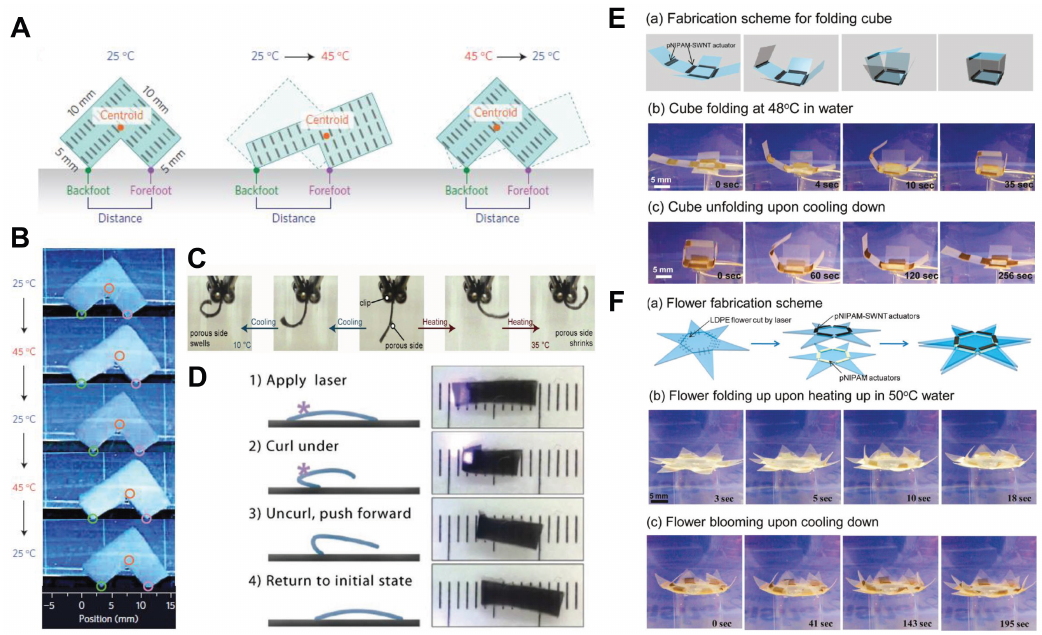
Figure 2. Thermo-responsive hydrogel actuators (HAs). ( A ) Basic diagram and mechanism for a unidirectional procession of L-shaped symmetric poly( N -isopropylacrylamide) (pNIPAM)/titanate(IV) nanosheet HAs (5 mm thick). ( B ) In the absence of substantial water uptake and release, distance between the nanosheets rapidly expands and contracts on heating and cooling, respectively, even in air, for which a hydrogel walker achieved a good forward motion. ( C ) Images of elastin-like polypeptide (ELP)–reduced graphene oxide (rGO) HAs reversibly curling in response to cooling or heating of the surrounding solution. ( D ) Photothermally actuated hygromorphic crawler. A hydrogel molded with a slight curvature was placed with porous side facing down. The laser was applied so as to induce gel curling.